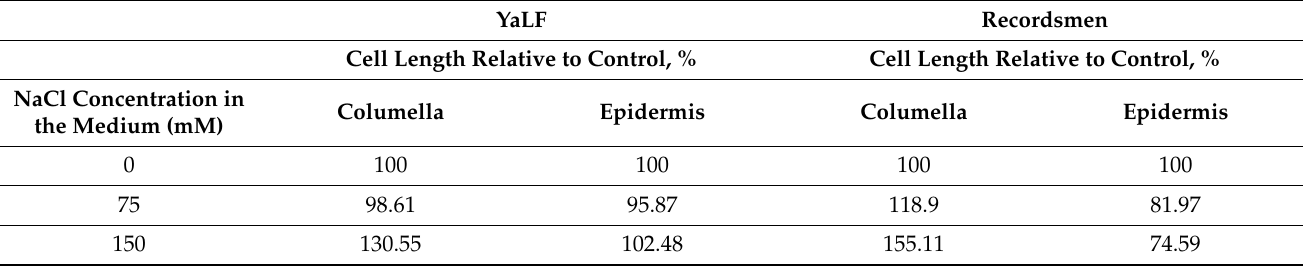
Table 1. The length of the tomato epidermis and columella cells.